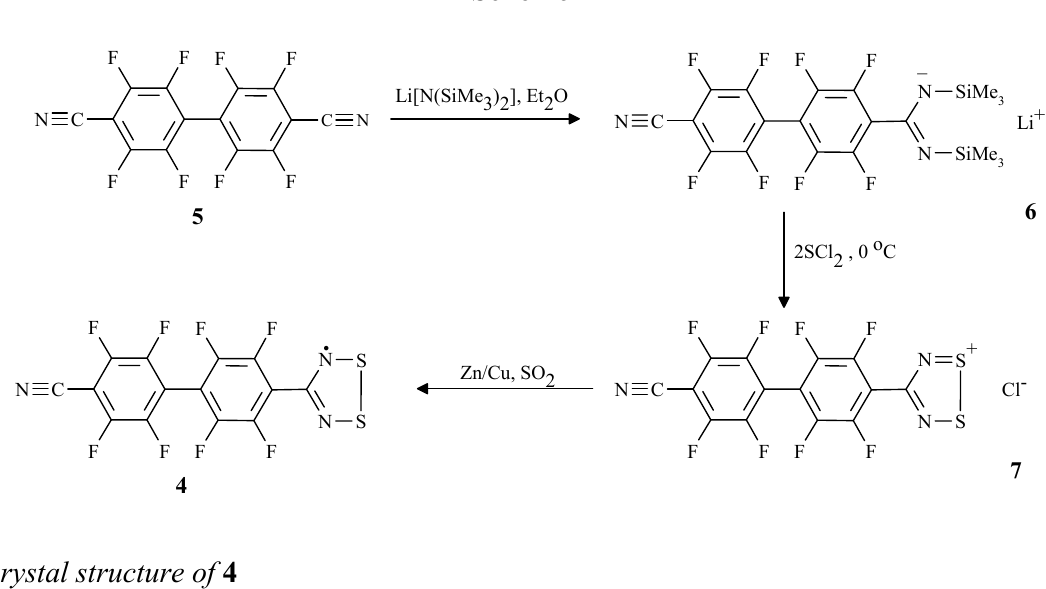
Figure 1. Molecular structure of 4 with atom labelling scheme